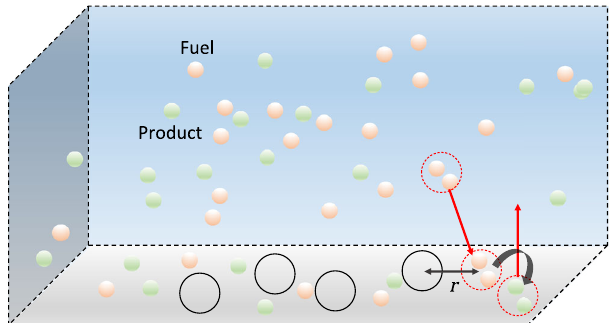
FIG. 6. Schematic of the active slab system. Small orange (green) spheres are fuel (products), and large hollow spheres are the active particles, which are confined to the surface and consume fuel at rate r . The products of the reaction diffuse out of the slab to the bulk system (reservoir of both fuel and products), while fuel molecules diffuse into the slab from the bulk to maintain constant chemical the slab, J f;p ≃ ð J f;p · ˆ e ⊥ Þ ˆ e ⊥ . Conservation of mass then